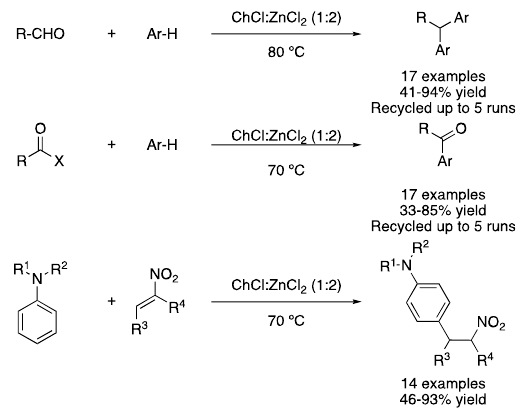
Figure 38. Friedel-Crafts-type alkylation/acylation.